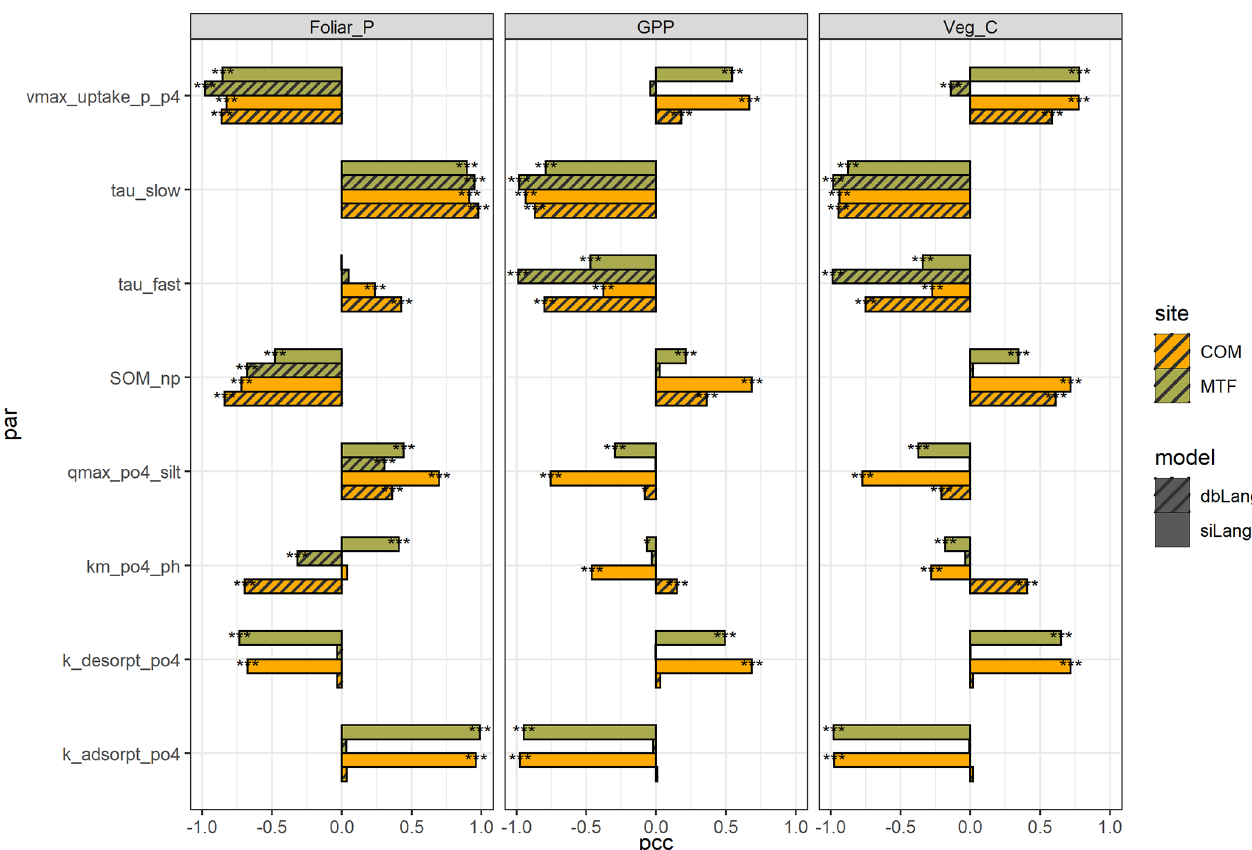
Figure 5. Partial correlation coefficient (pcc) values of eight main parameters of foliar P content, gross primary production (GPP), and vegetation C stock at the COM and MTF sites of the single-surface Langmuir model (siLang) and the double-surface Langmuir model (dbLang) in the Latin hypercube design (LHS) sensitivity runs. The eight parameters are as follows: the maximum plant P uptake rate (vmax_uptake_p_p4), the turnover rates of slow and fast soil organic matter (SOM) pools (tau_slow and tau_fast, respectively), the N:P ratio of the slow SOM pool (SOM_NP), the phosphate sorption capacity of fine soil (qmax_po4_silt), the correction coefficient of pH on Langmuir K m (km_po4_ph), and the absorption and desorption rate between P lab and P sorb (k_ adsorpt_po4 and k_desorpt_po4, respectively). The significance levels shown in figure (using asterisks) are as follows: p< 0 . 001 ( ∗∗∗ ), p< 0 . 01 ( ∗∗ ), and p< 0 . 05 ( ∗